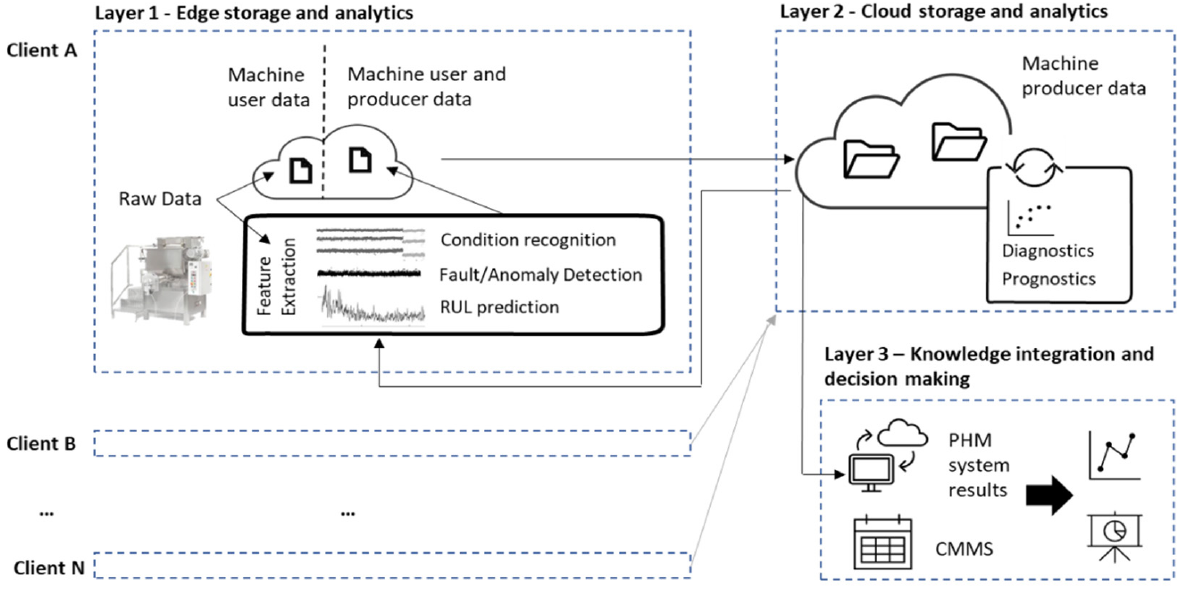
Figure 3. The proposed framework .